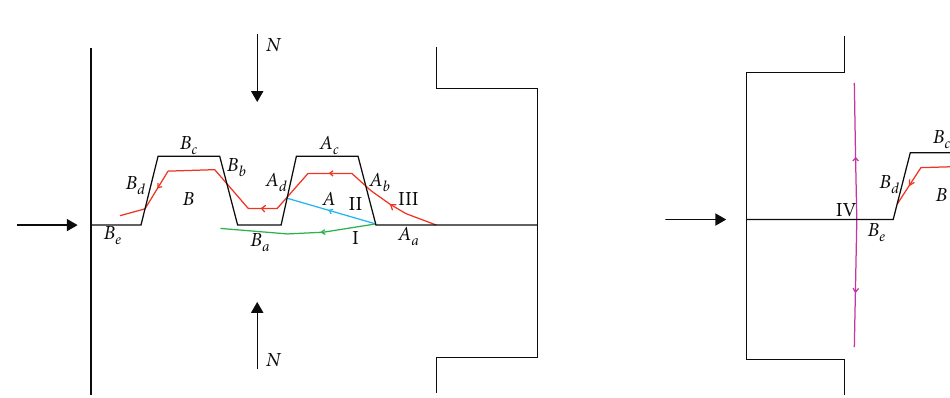
Figure 8: Crack development of double mortise-tenon joint with auxiliary pretightening device in compression